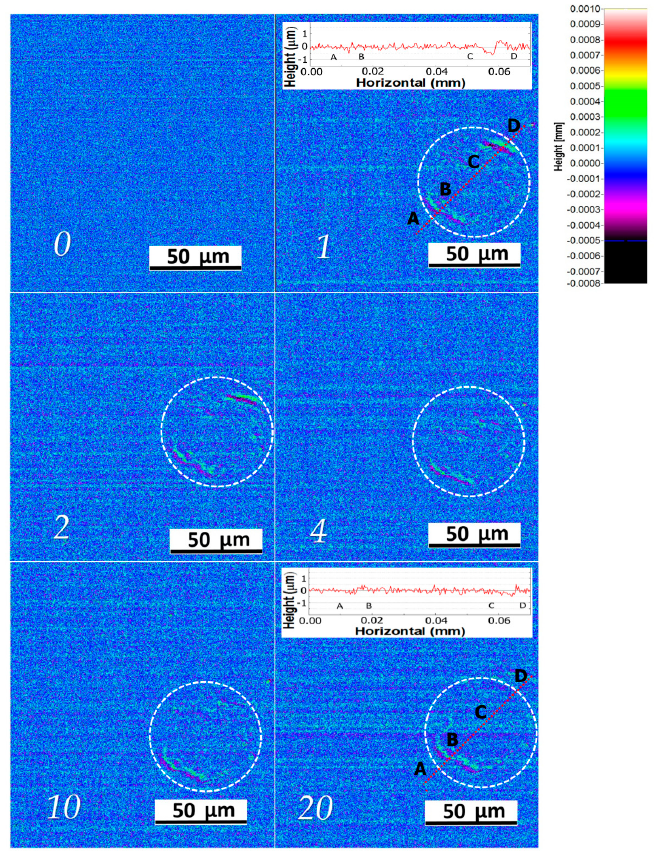
Figure 9. A sequence of measurements of the lower contact during a hot 20 mA 4 V Direct Current (DC) switching sequence at 500 µN normal contact force. 0.15 mm × 0.15 mm region after 0, 1, 2, 4,10 (DC) switching sequence at 500 µ N normal contact force. 0.15 mm × 0.15 mm region after 0, 1, 2, 4,10 and 20 cycles. and 20